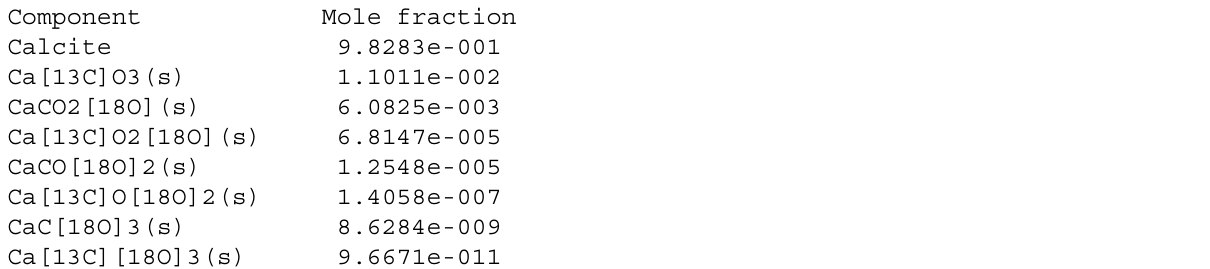
Table 58. Mole fractions of isotopic components in a marine carbonate solid solution.